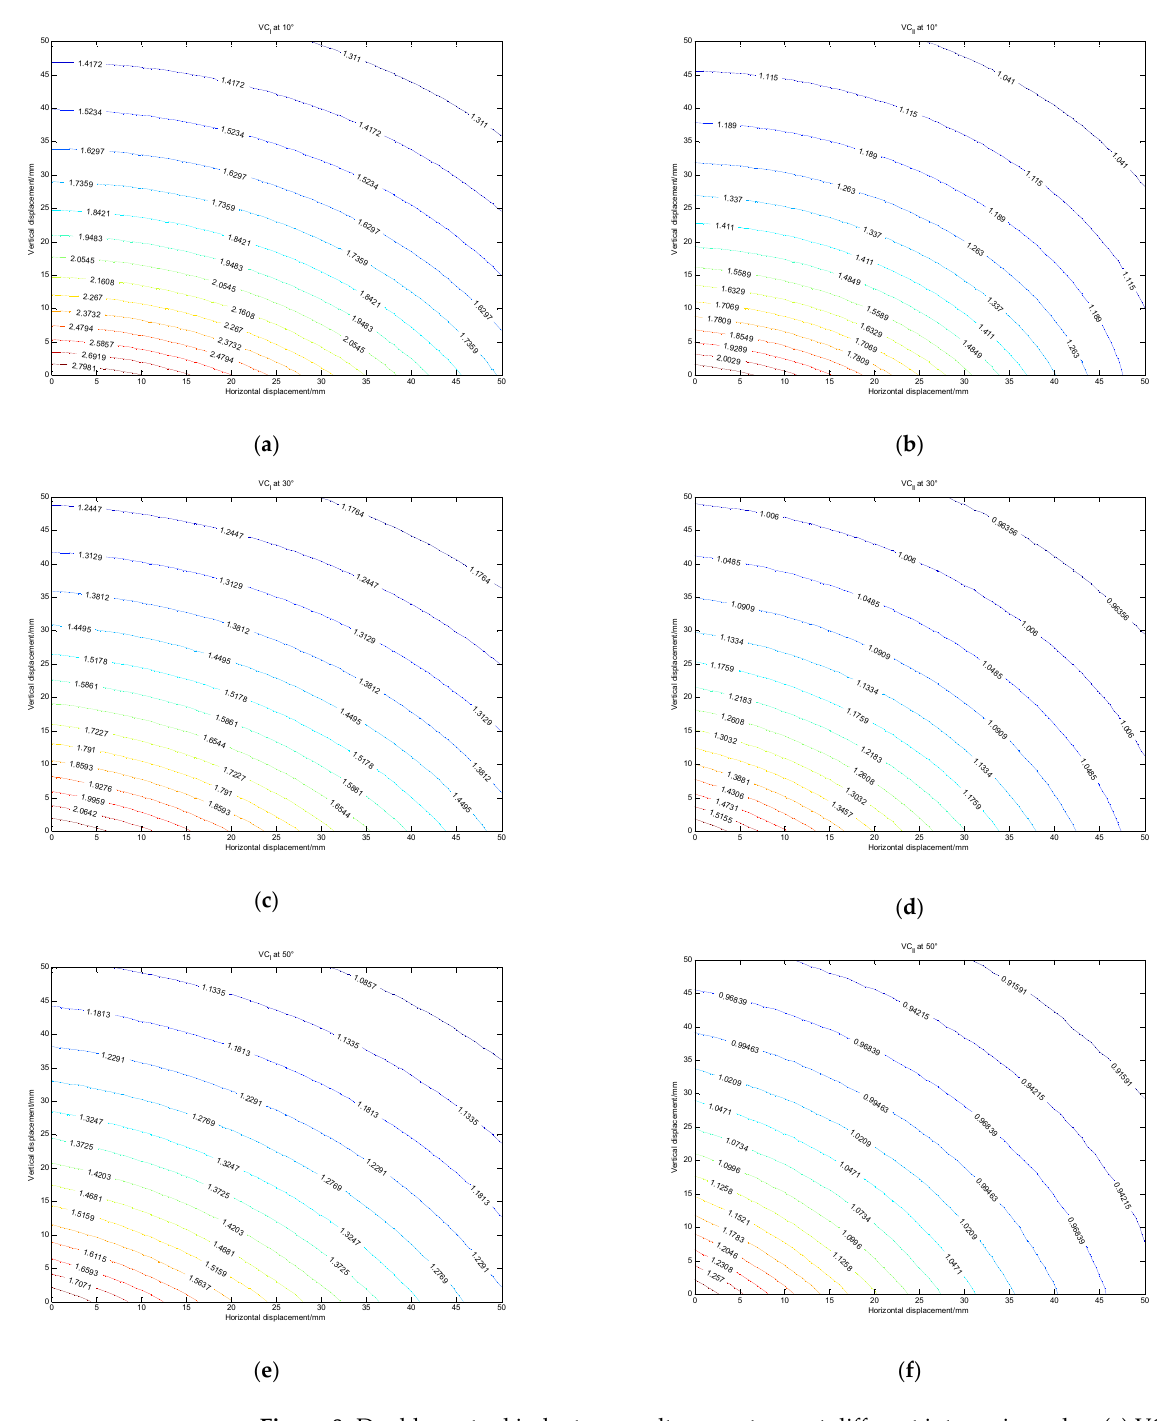
Figure 7. Three-dimensional graph of ( a ) type I mutual inductance voltage, ( b ) type II mutual in- ductance voltage versus horizontal displacement and vertical displacement at different inter-axis angles. (10°, 30°, and 50° from top to bottom).